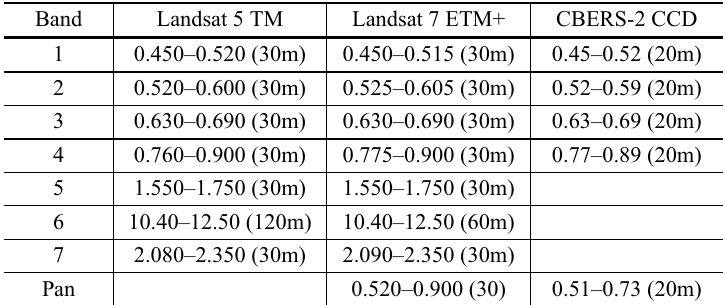
Comparison between Landsat 5 TM, Landsat 7 ETM+ and CBERS-2 CCD spectral range-spatial